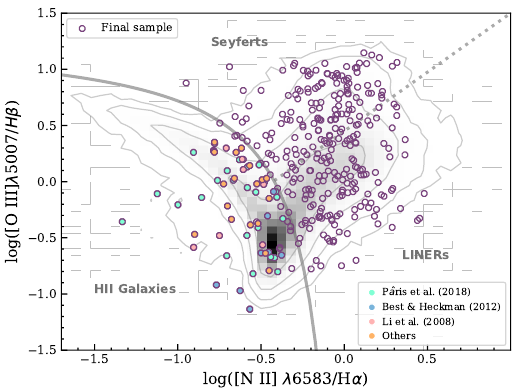
Figure 2. The BPT diagram with our final sample (denoted by purple circles). The solid curve is the classification curve from Kauffmann et al. [39] and the dotted line shows the division of Seyferts and LINERs (Low Ionization Nuclear Emission-Line Regions) from Schawinski et al. [45]. The contours show our parent sample